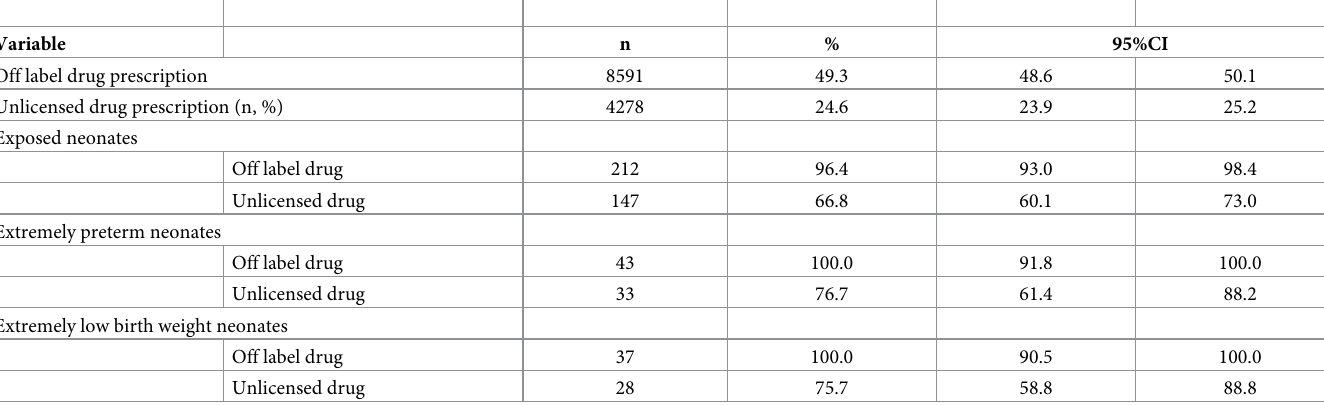
Table 2. Prevalence of newborns administered off-label and unlicensed medicines in an intensive care unit according to gestational age and birth weight.